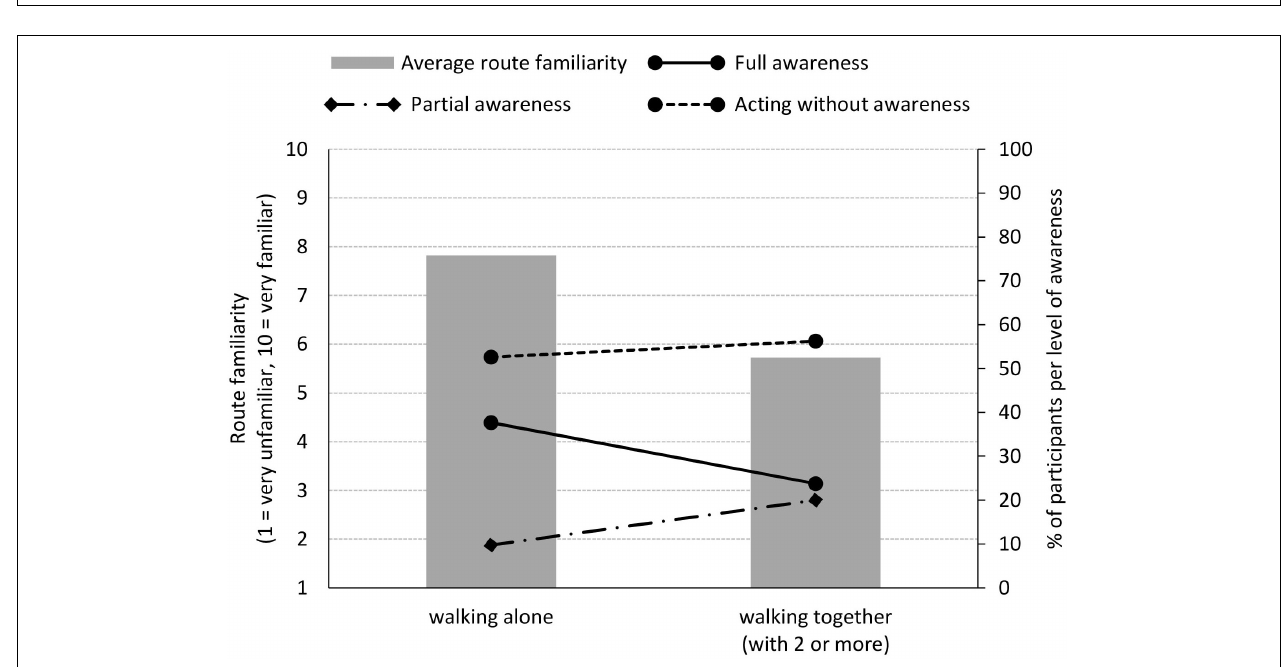
FIGURE 6 | Distribution of self-reported route familiarity.